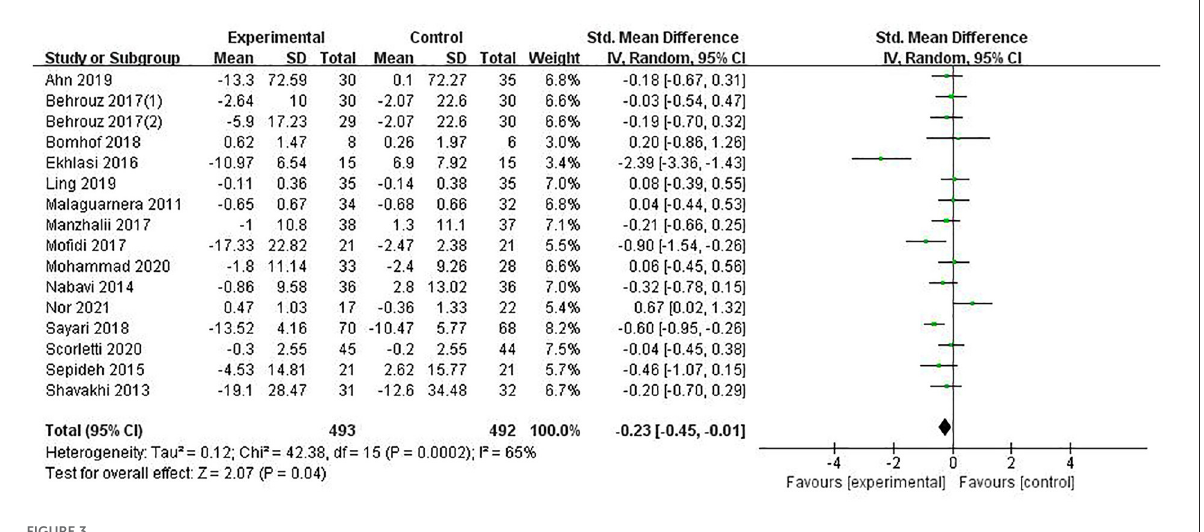
FIGURE3 The role of PPS in Glucose in patients with